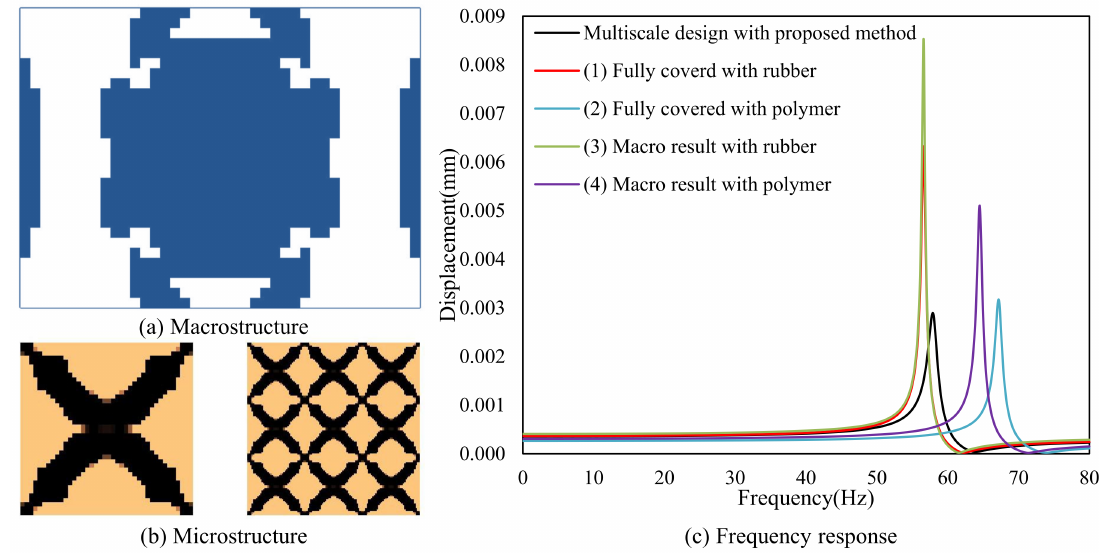
Figure 29. The design result. ( a ) The macrostructure. ( b ) The microstructure and unit cell. ( c ) The frequency